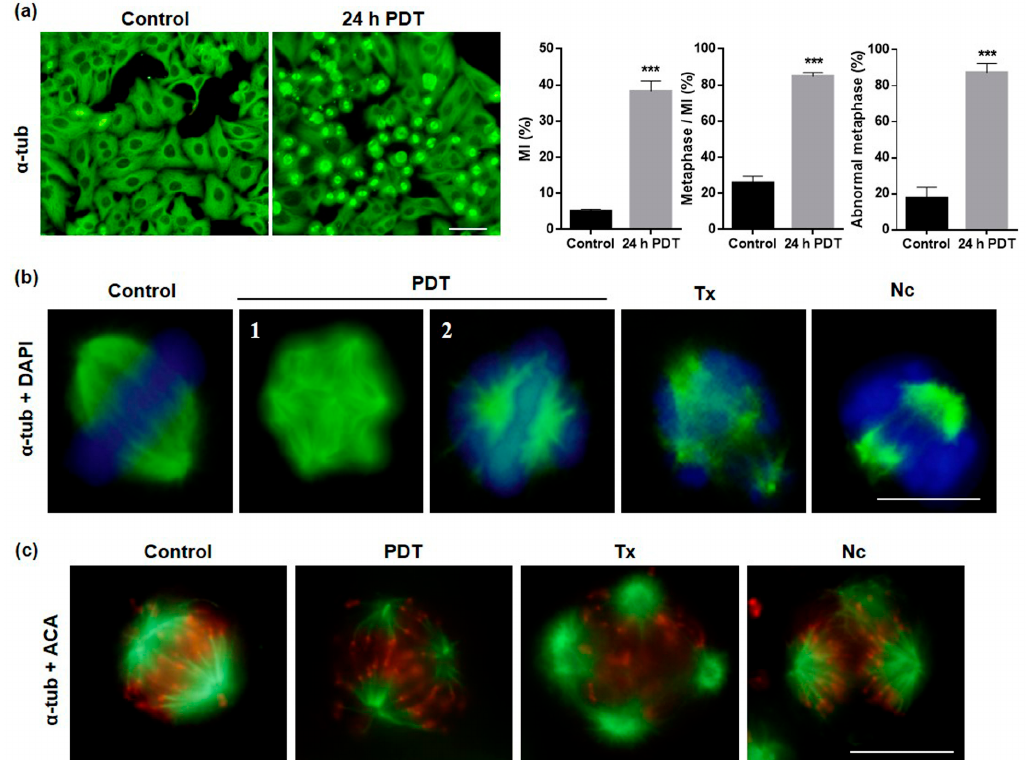
Figure 5. Microtubular and chromosomal alterations after PDT. Cells were evaluated 24 h after treatments by IF for α -tubulin. ( a ) Morphological changes in α -tubulin after 24 h PDT. Mitotic index, number of metaphases/MI and percentage of abnormal metaphases (*** p < 0.001). Scale bar: 50 µm. ( b ) Mitotic spindles of control and after MAL-PDT, Tx and Nc treated cells showing normal and altered morphology, respectively. DNA was stained with DAPI. (1) Multipolar cell, (2) aberrant bipolar with altered disposition chromosome on the equatorial plate. Scale bar: 10 µm. ( c ) Mitotic spindles (fluorescing in green) and centromeres (fluorescing in red) determined by IF for α -tubulin and ACA, respectively. Scale bar: 10 µm.